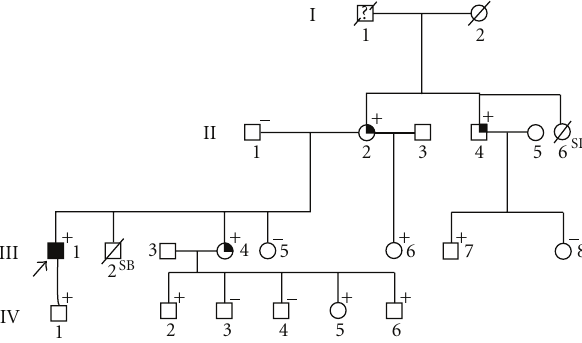
Figure 3: The pedigree of the examined family, the proband is marked by arrow. He is the only clinically a ff ected (black symbol), + indicates family members who are heterozygous for the p.V79I mutation, − indicates family members who were genetically assessed and found to be nonmutation carriers. The three family members with borderline HCM are marked by a black